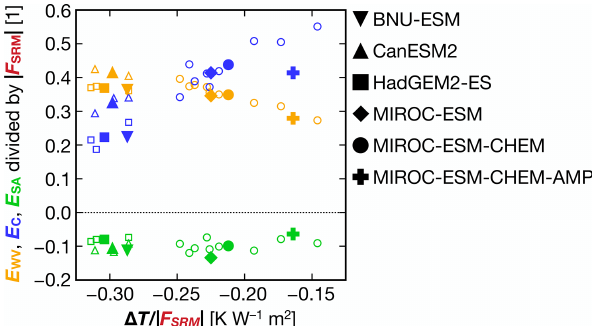
Figure 6. Same as Fig. 5 but for the SW total reactions normalized by the absolute value of the SRM forcing. Note that the difference in the surface air temperature ( x axis) is also divided by | F SRM |